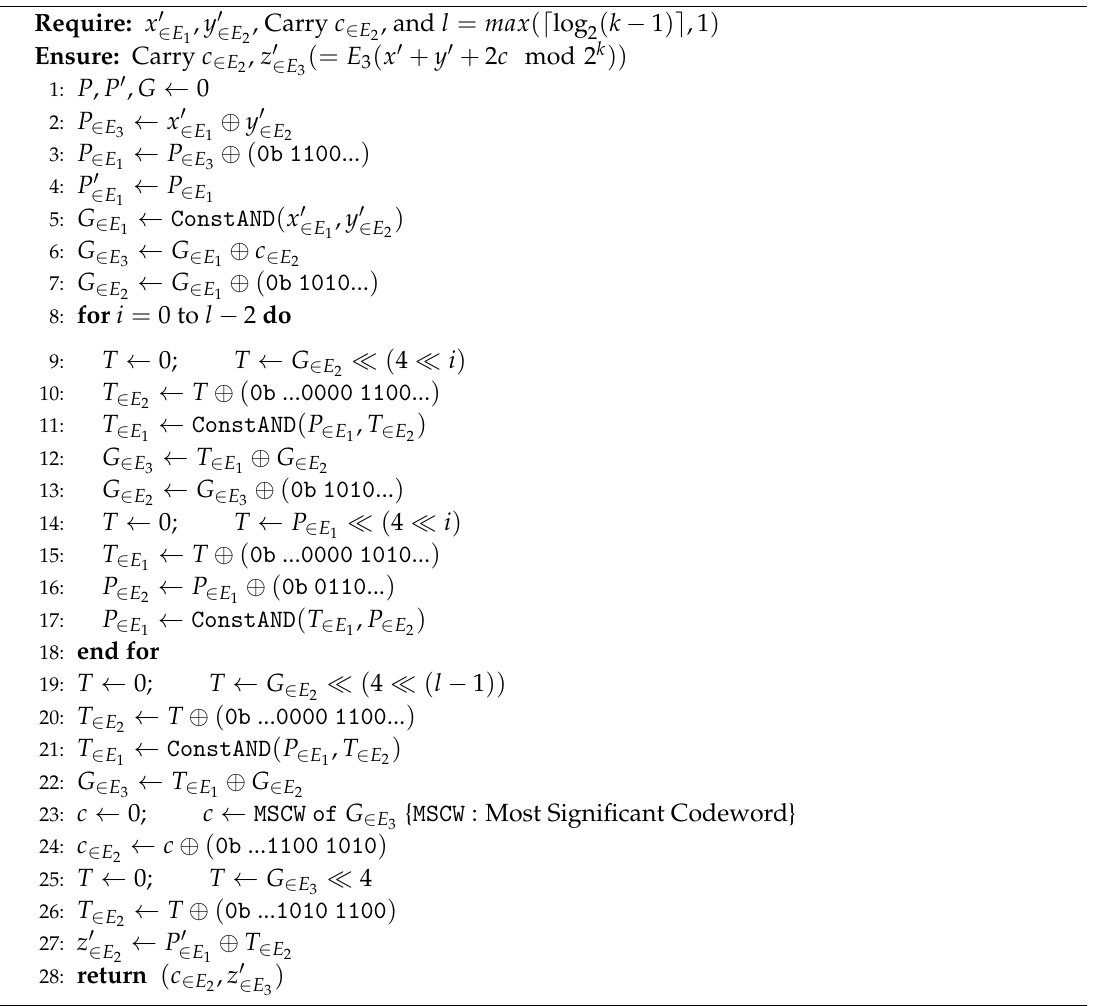
Algorithm A4: BKSAdder Won , Won’s KS Adder Applied to Power-balancing Methods